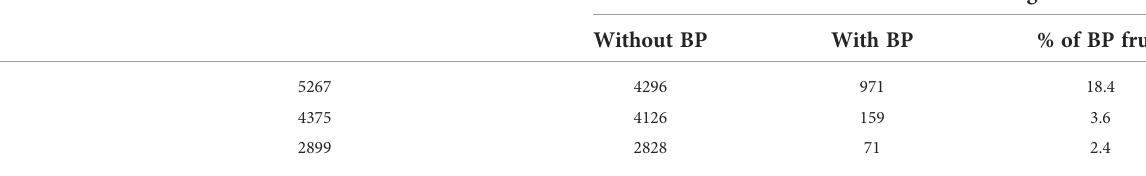
TABLE 1 Number of total fruits used for ‘ Granny Smith ’ -GS, ‘ Brook fi eld ’ -BF and ‘ Fuji ’ -FJ apples coming from commercial orchards for BP prediction. Cultivar Total number of harvested fruits Fruit within each class after storage Without BP With BP % of BP fruit